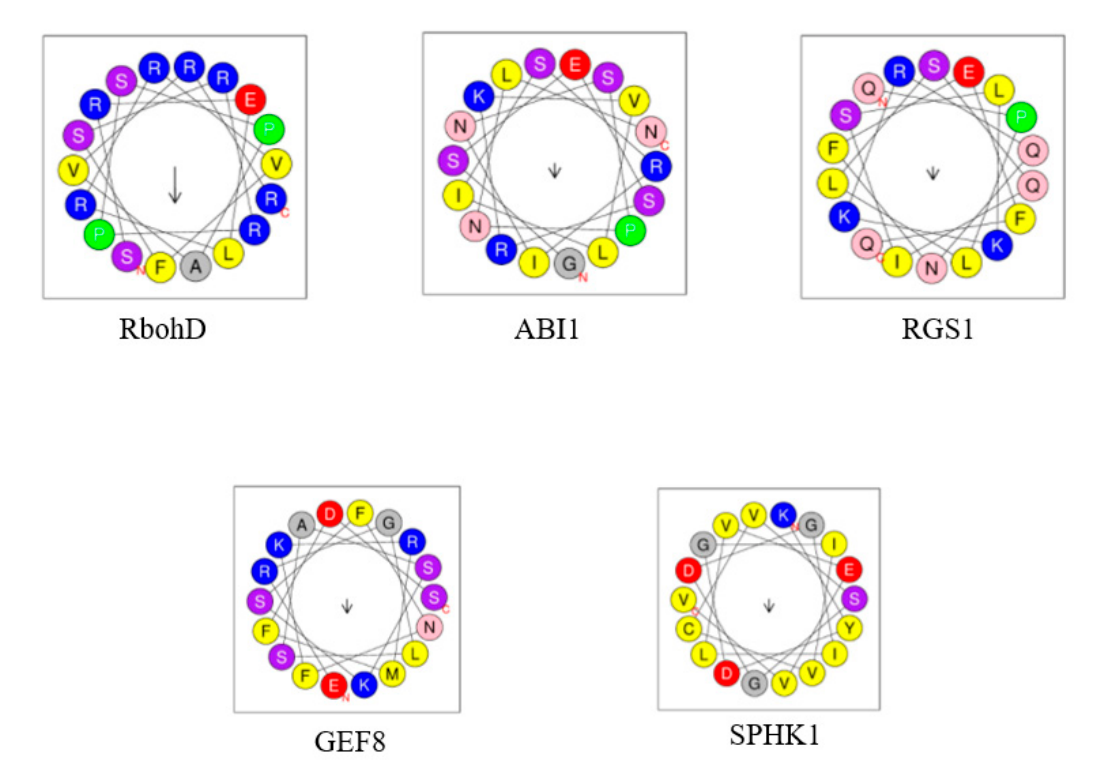
Figure 3. PA-binding folds of Arabidopsis proteins involved in plant hormone (abscisic acid) signaling. Shown are amphipathic α -helix projections of a minimal characteristic PA-binding domain obtained with “Heliquest” software [90]. The arrows indicate the hydrophobic moment. Basic and hydrophobic residues are shown in blue and yellow, respectively. PA-binding motifs were obtained from published data: AtRbohD [30], AtABI1 [32], AtRGS1 [91], AtGEF8 [75] and AtSPHK1 [86]. The sequences of PA-binding motifs are as follows: 140-SRELRRVFSRRPSPAVRRFD-159 (AtRbohD), 63-GSESRKVLISRINSPNLNMK-82 (AtABI), 250-QPLLSQISLKKRQNFEFQRM-269 (AtRGS1), 6-ERGLSASKSFNFKRMFDSSS-25 (AtGEF8), 175-KYDGIVCVSGDGILVEVVNG-194 (AtSPHK1).